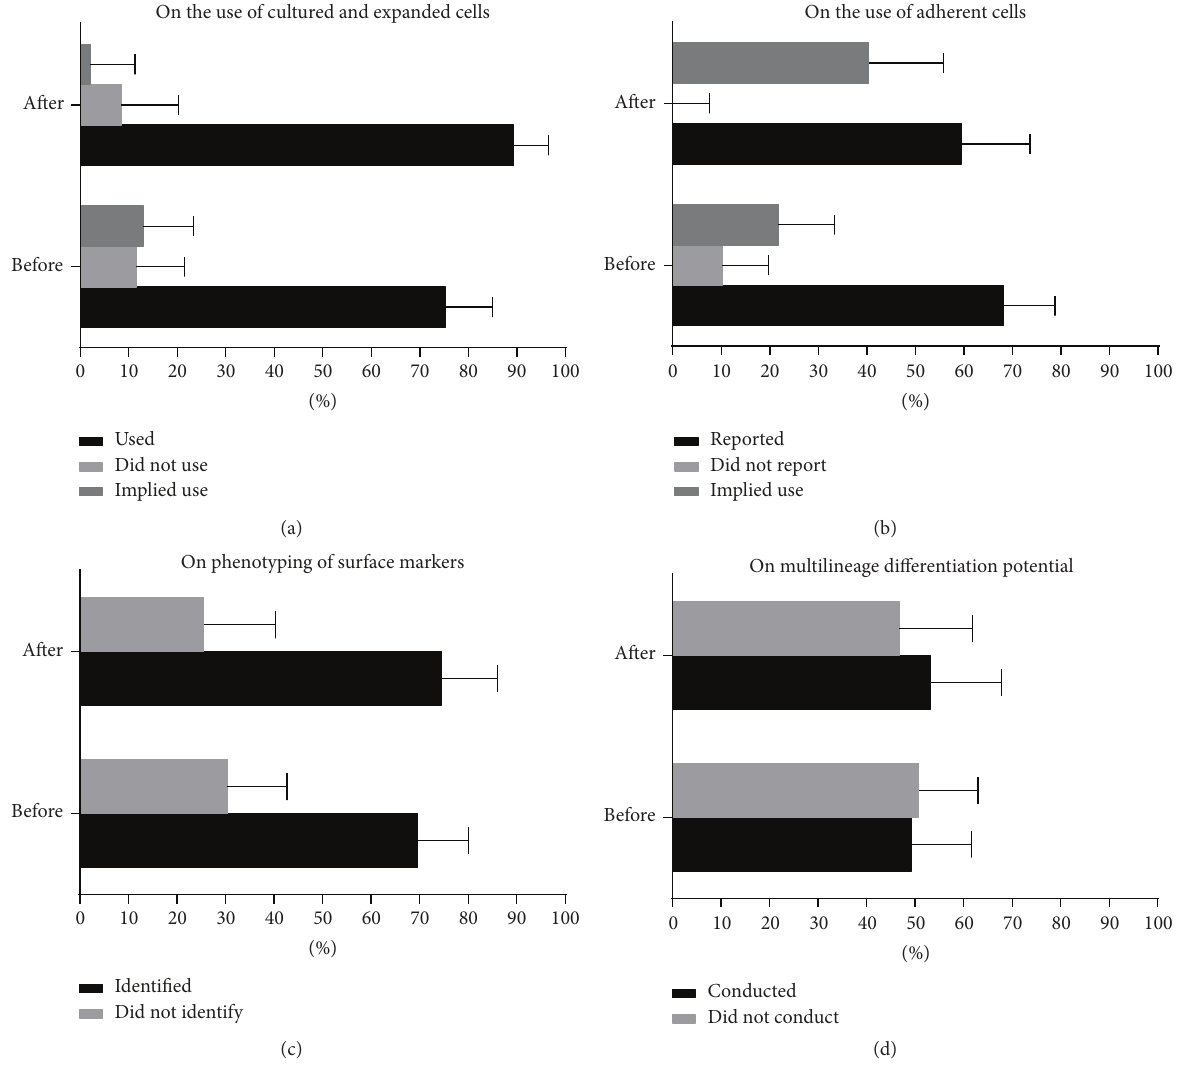
Figure 1: Impact of IFATS and ISCT on reporting of the characteristics of the ASC. Papers reporting on the characteristics of the cells transplanted or delivered to human patients or animal subjects were grouped and assessed before ( 𝑛 = 69 ) and after ( 𝑛 = 47 ) publication of the IFATS and ISCT